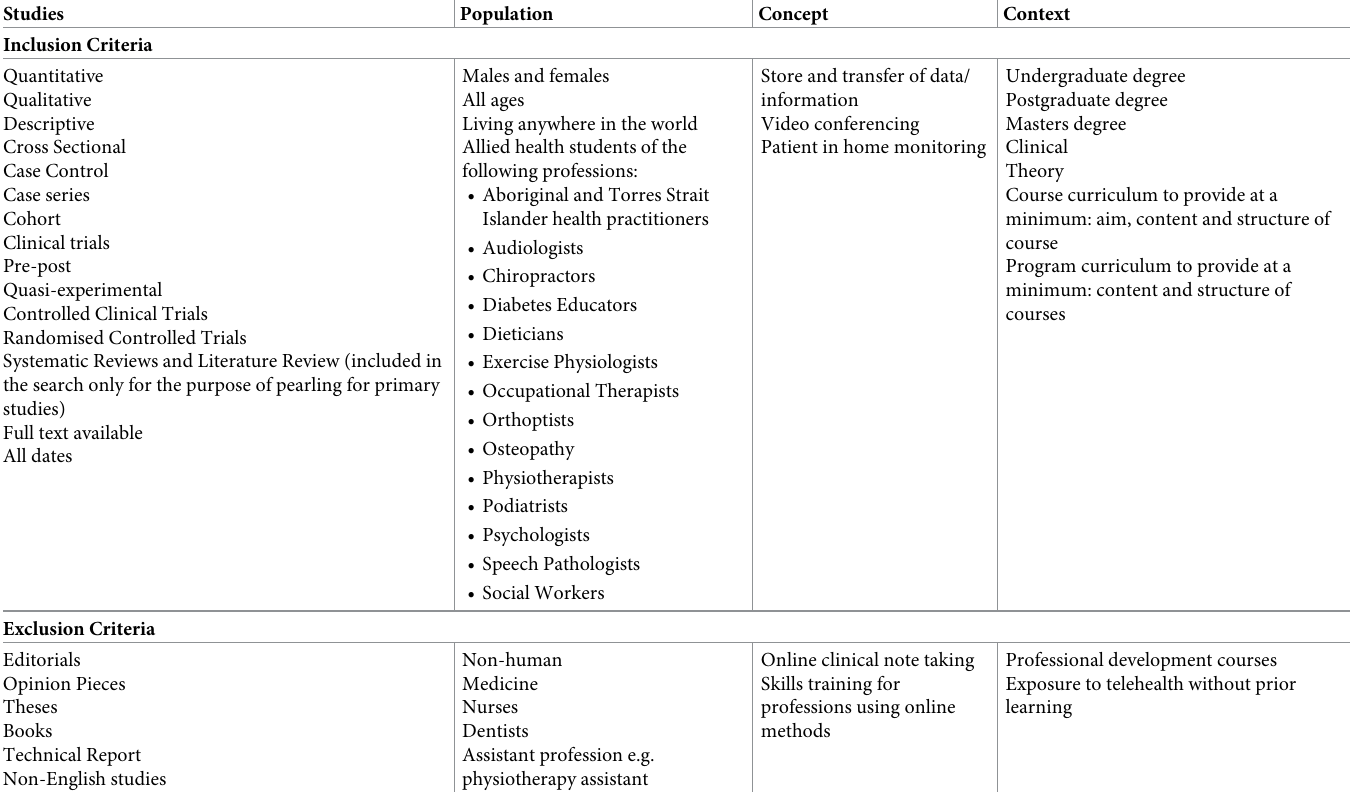
Table 1. Eligibility